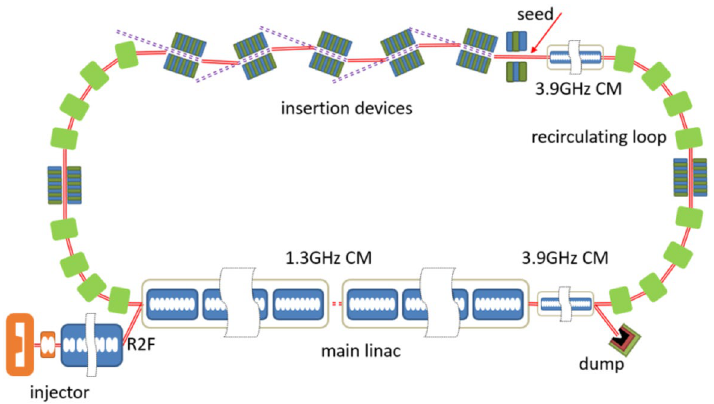
Figure 1. The layout of the EUV light source. Round-to-flat (R2F) technique is adopted in the